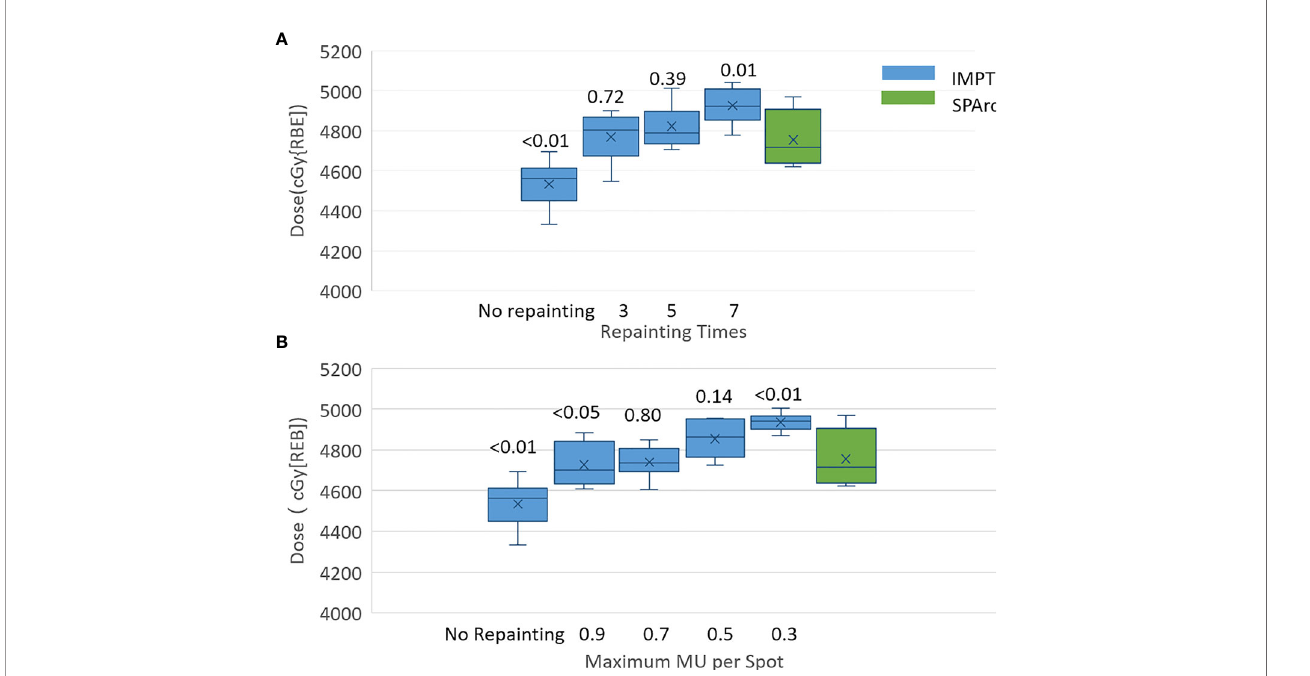
FIGURE 5 | Single fraction 4D dynamic dose of patient #10 for target D99 along with (A) volumetric repainting times and (B) maximum MU per spot. The top value is the p value for the comparison of target D99 between IMPT with repainting and SPArc without